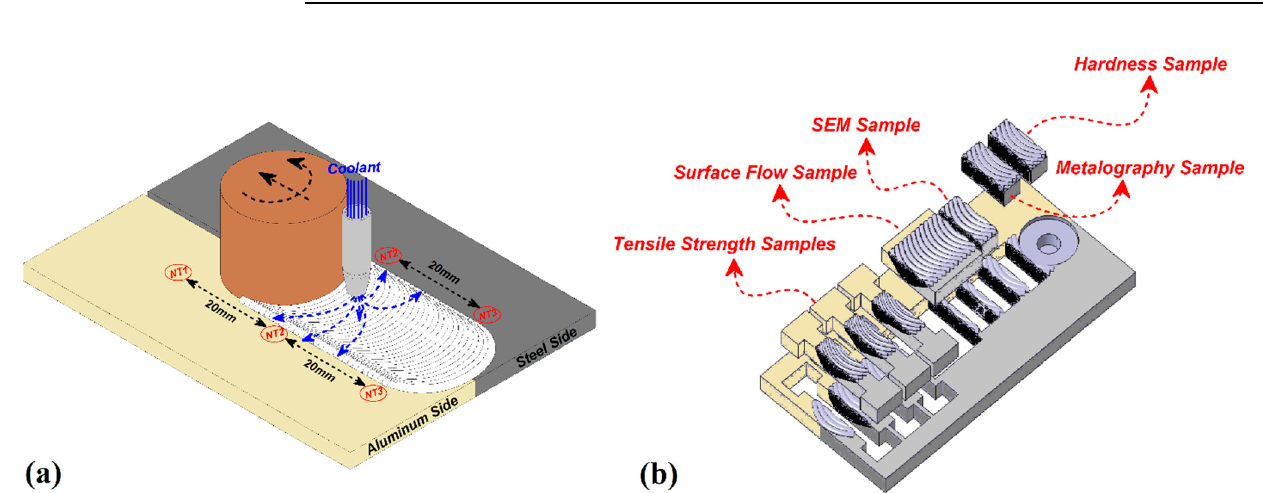
Figure 1. ( a ) Schematic of thermocouple places and ( b ) mechanical testing samples. Table 3. Friction stir welding (FSW) process